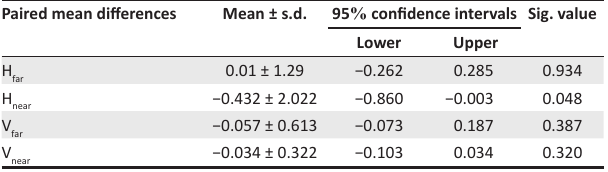
TABLE 4: The mean differences of heterophoria measurements and 95 % exact confidence intervals around the means. Paired mean